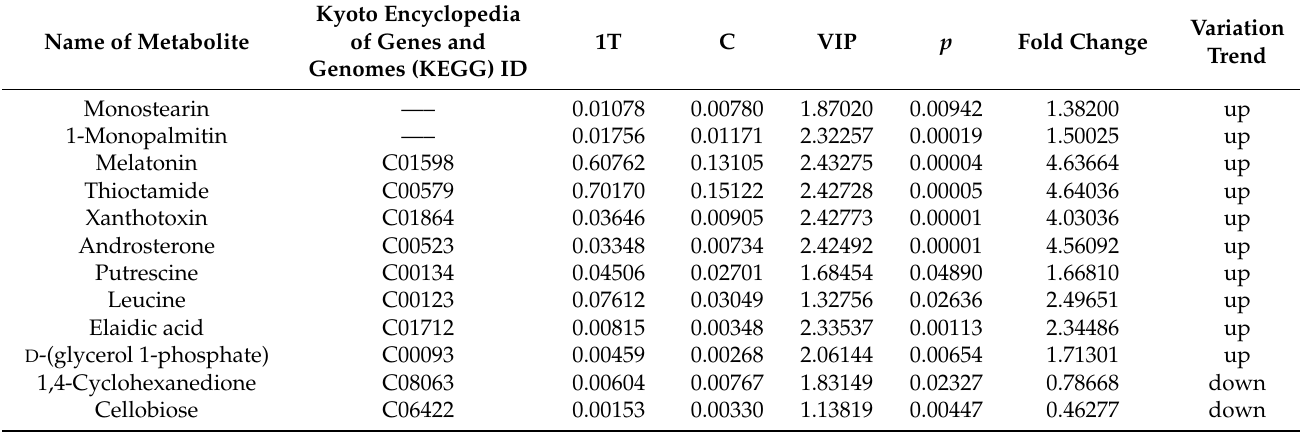
Table 3. Differential metabolites: 1T and C were the relative quantitative values of the substance in the treatment group and control group, respectively. The VIP is to compare this group of substances with the OPLS-DA model obtained by predicting significance of variables. The p -value is obtained by the t -test for the substance in the group comparison. p < 0.05.